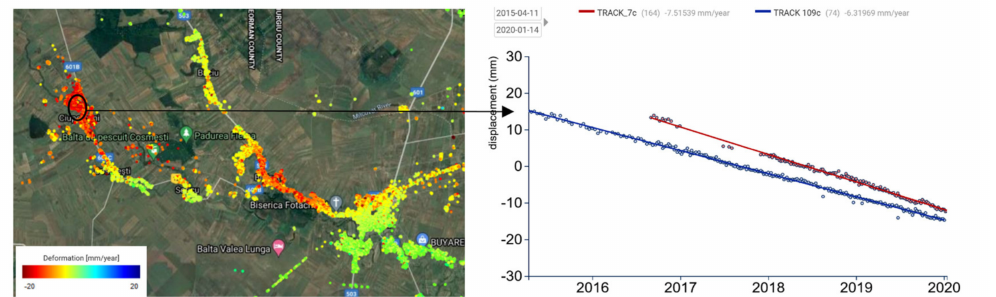
Figure 13. PSInSAR measurement results in Videle area (Southern